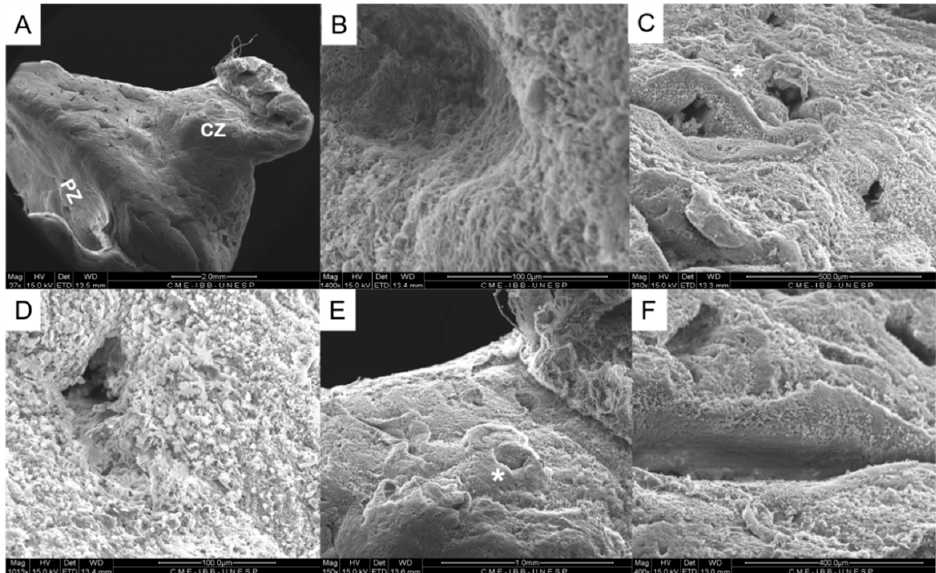
Figure 6. Scanning electronic microscopy. Ultrastructural lower magnification distinguishing the central and peripherals zones (ZC to the central zone and ZP to the peripheral zone, in picture ( A ). It is possible to visualize the capsule ( B ), the peripheral zone with the acinus (asterisk) ( C ), whose epithelium can be observed in higher magnification ( D ), the urethra prostatic in the central zone (asterisk) ( E ), surrounded by the prostatic ducts ( F